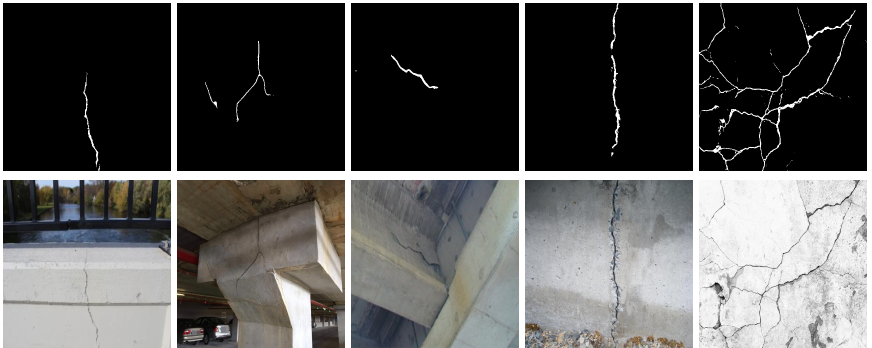
Figure A1. Inference on concrete structures other than sidewalks. From left to right, the first three images are taken from bridges, the fourth image is of a building foundation, and the last image is of a concrete wall. First Row: predicted segmentation mask by UNet model. Second Row: corresponding RGB